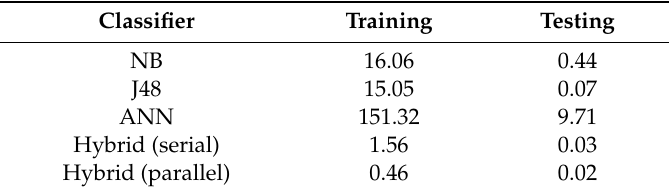
Table 3. Processing time comparison